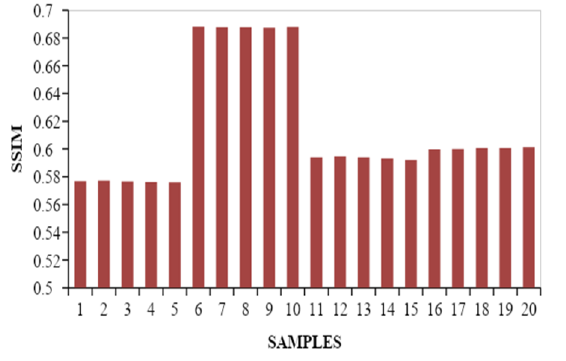
Fig.5 SSIM representation for Liver CT Scans bearing Malignant Tumor